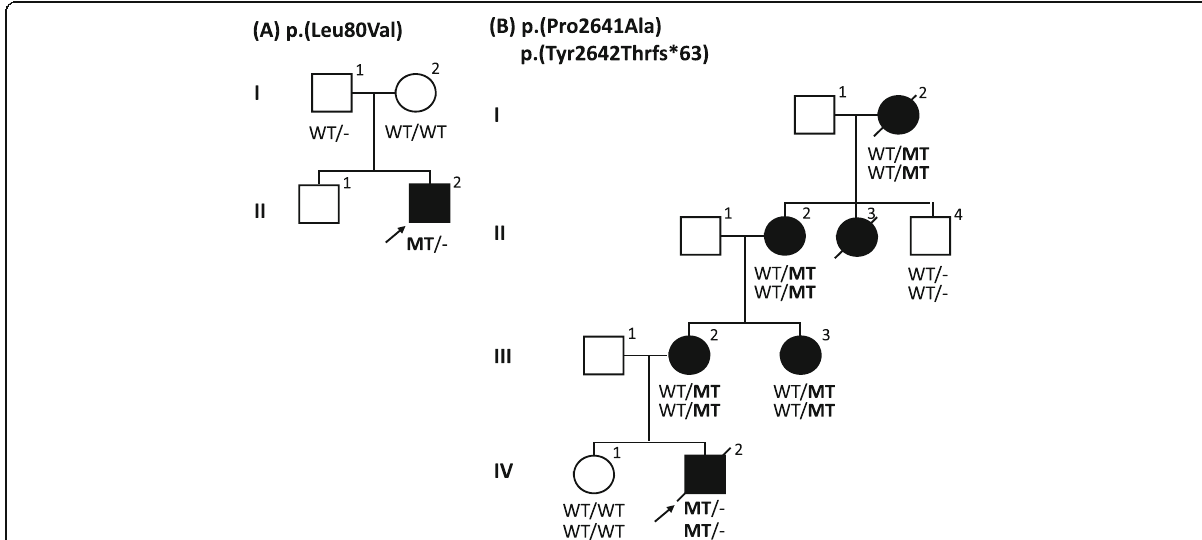
Fig. 2 Family pedigrees with their respective mutations. Squares represent males, circles represent females, black-filled symbols represent affected individuals and a + or − sign denotes the presence or absence of FLNA mutations. a Pedigree of case A, the Indian patient (proband) with a de novo FLNA missense mutation p.(Leu80Val) and his unaffected family members. b Pedigree of case B, the Bosnian patient with a frameshift p.(Tyr2642Thrfs*63) and a missense mutation p.(Pro2641Ala) in